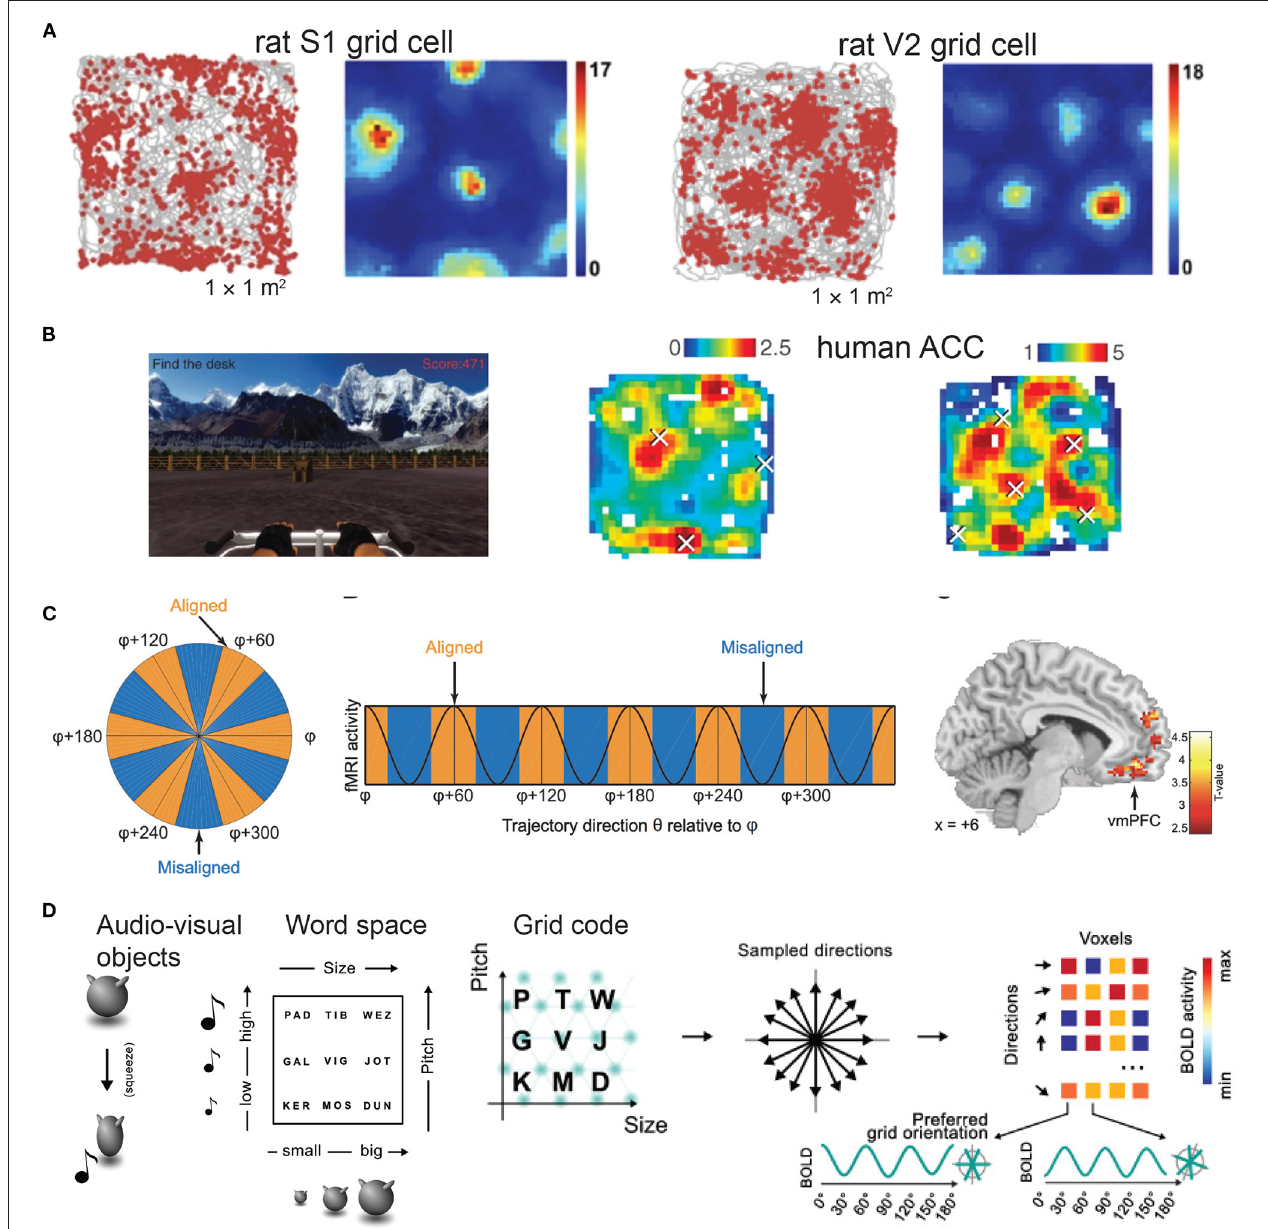
FIGURE 1 | Grid-like responses across rodent and human brains. (A) Electrophysiological data show grid-like firing patterns from the rat primary somatosensory cortex (S1) (images are modified from Long and Zhang, 2021, Cell Research ; reprinted with permission, Creative Commons CC BY license) and the secondary visual cortex (V2) while animals navigated in an open field arena. Color bar shows the firing rate in spikes/s (figure is modified from Long et al., 2021a, bioRxiv). (B) Human invasive electrophysiological data show grid-like representations in the anterior cingulate cortex during a virtual navigation task. Color bar shows the firing rate (Hz) (figures are modified from Jacobs et al., 2013, Nature Neuroscience ; reprinted with permission, from the authors and Springer Nature). (C) Human fMRI data show grid-like representations in the ventromedial prefrontal cortex (vmPFC) during a two-dimensional olfactory navigation task (figures are modified from Bao et al., 2019, Neuron ; reprinted with permission, from the authors and Elsevier). (D) Left panel: example of audiovisual object—Nine audiovisual objects were created by manipulating the size of a shape and the pitch of an associated sound, produced during a short squeezing animation. Middle panel: Each audiovisual object was given an abstract name, that could be conceived as a location in a 2D word space. Right panel: Illustration of detection of grid code (figures are modified from Vigano et al., 2021, Neuroimage ; reprinted with permission, from the authors and Elsevier). and it is explained as a low-dimension sparse representation of et al., 2020; Zhang et al., 2022). Specifically, the grid-like the cognitive map. Whereas in RNNs, recurrent dynamics can representation is the eigenvector of the state-space transition generate stable ring or torus-like attractors that are associated matrix derived by the successor representation (SR) algorithm,